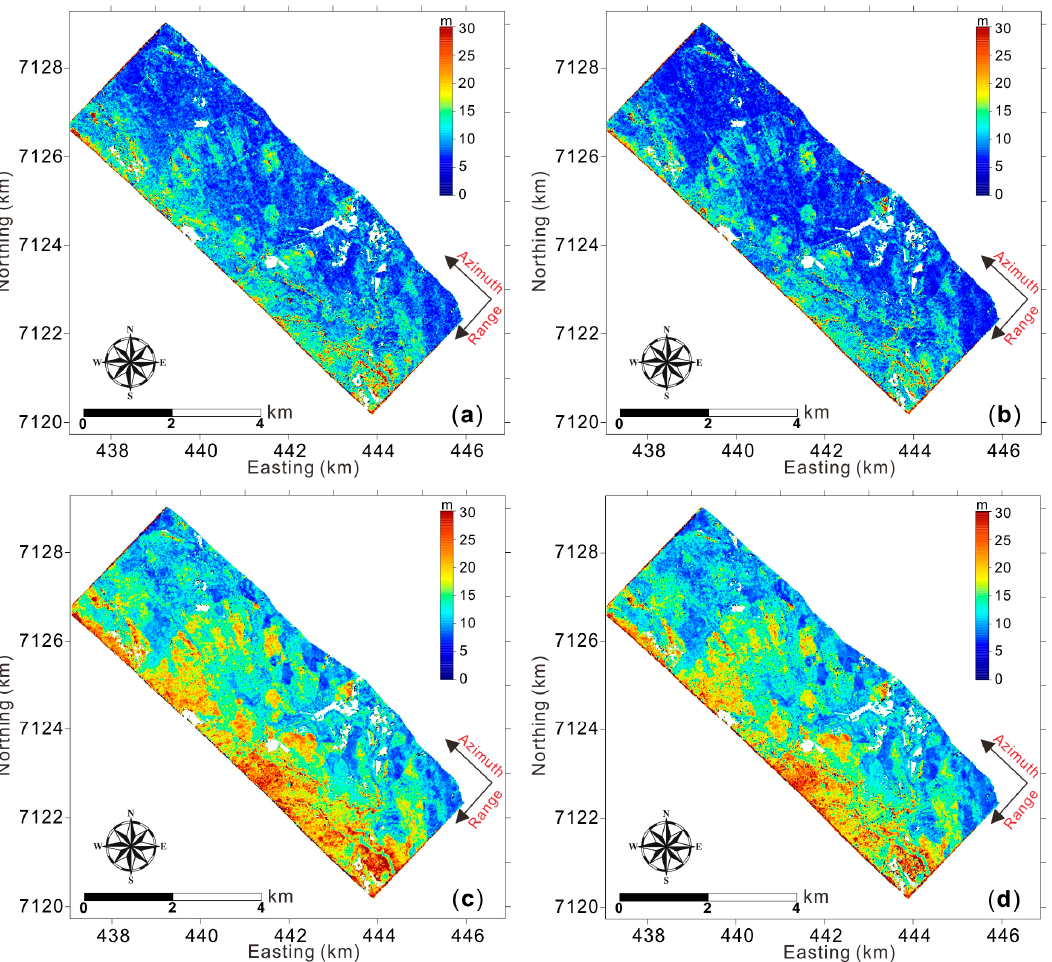
Figure 2. Forest height inversion results from four cases of inversion configurations. ( a ) Image 1-2 with single baseline PolInSAR (SBPI); ( b ) Image 1-3 with SBPI; ( c ) Image 1-2 as the first baseline B 1 with dual-baseline PolInSAR (DBPI); ( d ) Image 1-3 as the first baseline B 1 with